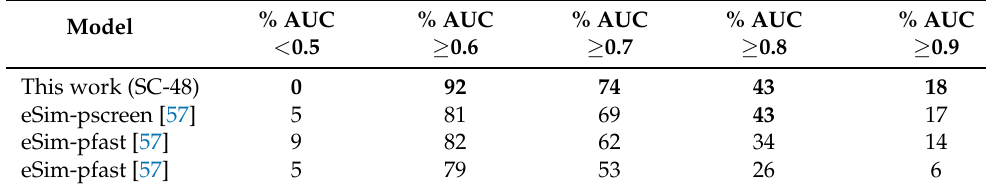
Table 3. Comparison of percentages linked to the different methods that fit a specific AUC threshold.